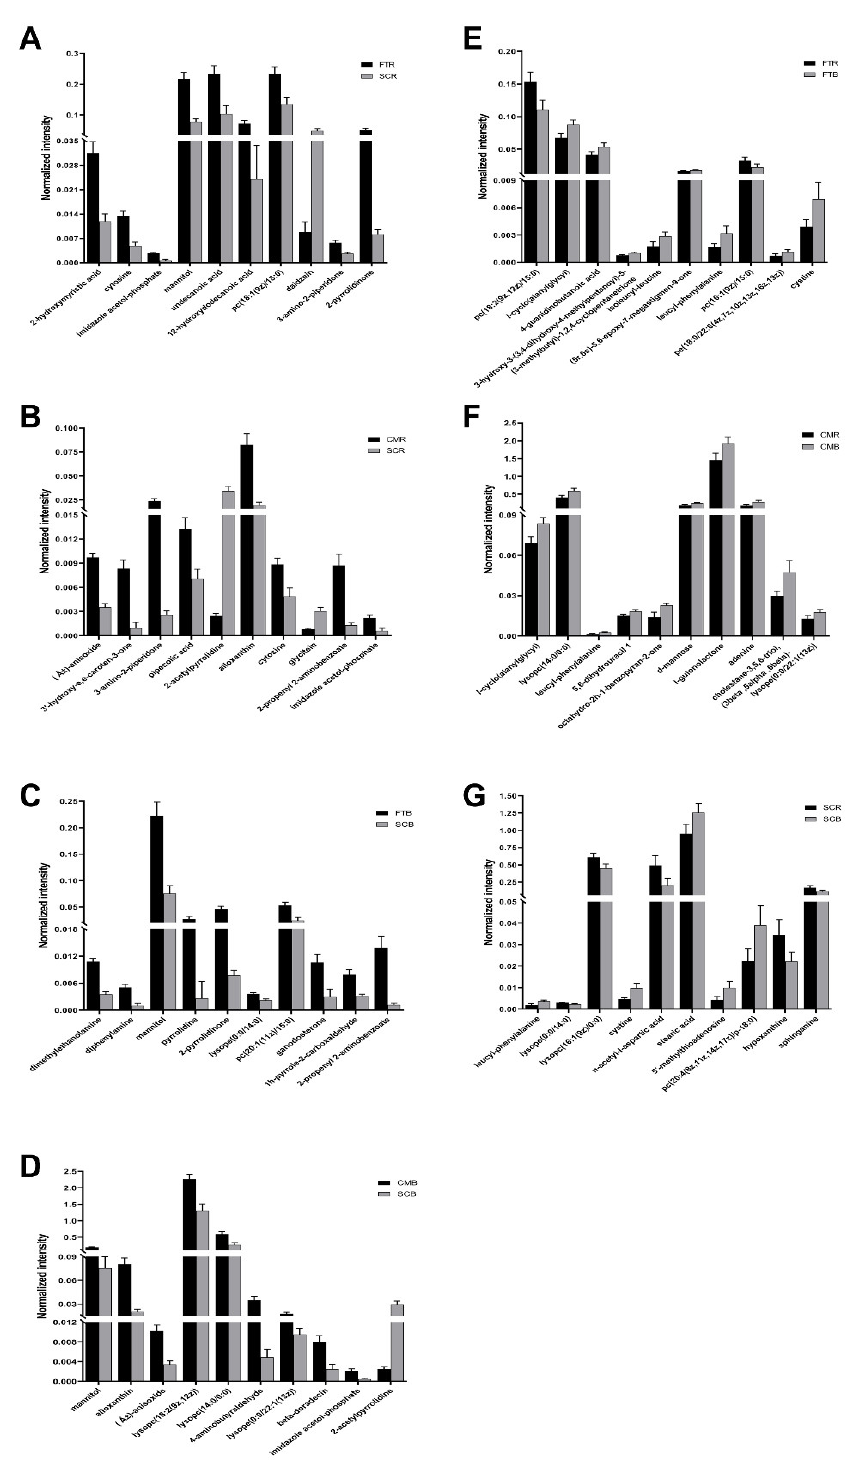
Figure 2. Top 10 differential metabolites based on the lowest p -values between: ( A ) Shaoxing duck and Fenghua teal yolks (raw samples); ( B ) Shaoxing duck and captive mallard yolks (raw samples); ( C ) Shaoxing duck and Fenghua teal yolks (boiled samples); ( D ) Shaoxing duck and captive mallard yolks (boiled samples); ( E ) raw and boiled egg yolk samples of Fenghua teals; ( F ) raw and boiled captive mallard egg yolk samples; ( G ) raw and boiled egg yolk samples of Shaoxing ducks. The X -axis indicates the metabolites. The Y -axis represents the normalized area for the metabolites. The plot shows the means with SEMs. Between the FTR and FTB groups, the 10 metabolites that differed the most were pc(18:2(9z,12z)/15:0), l-cyclo(alanylglycyl), 4-guanidinobutanoic acid, 3-hydroxy-3-(3,4-